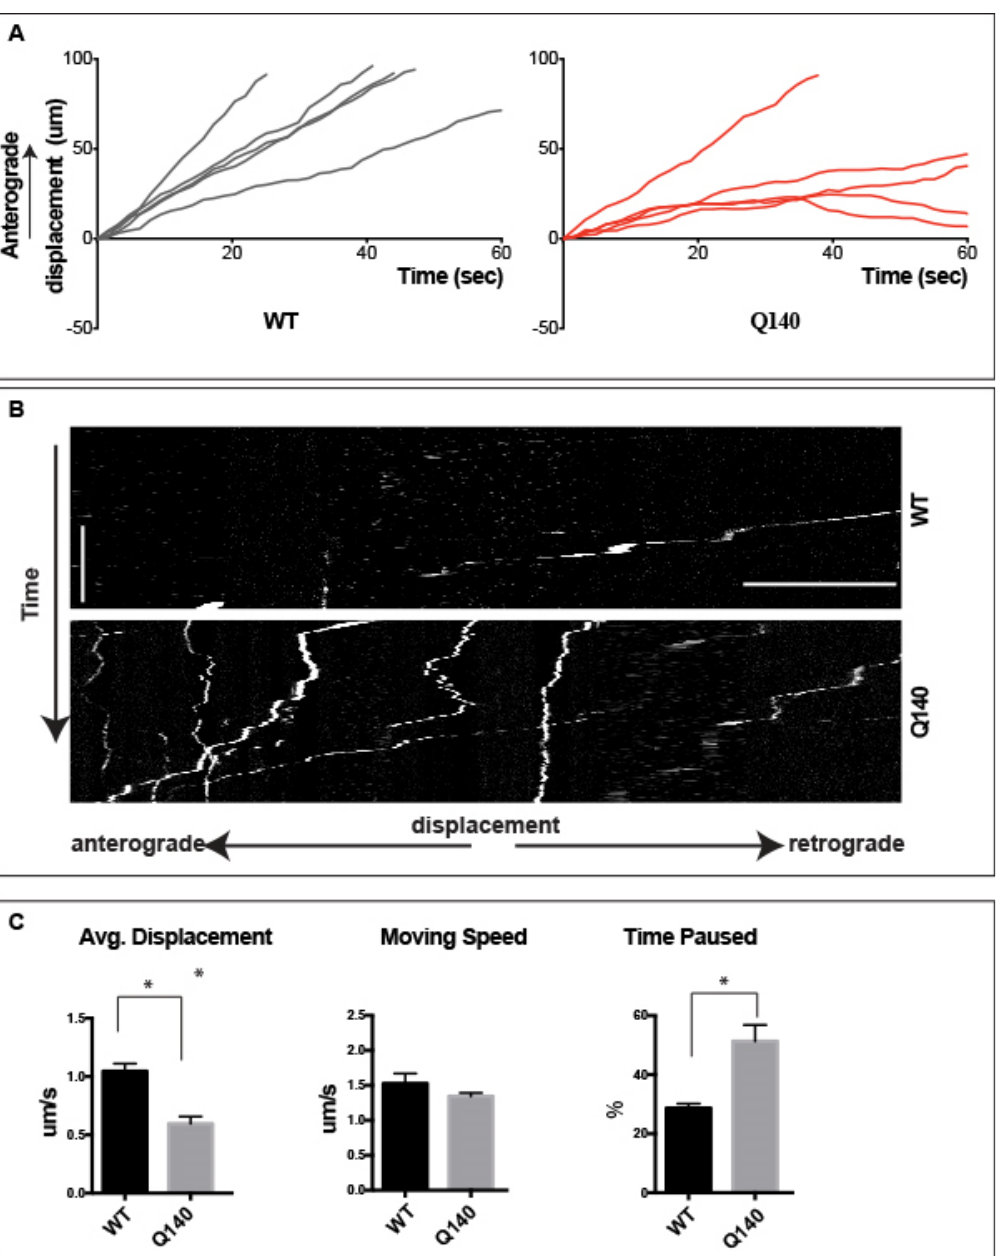
Figure 3. Perturbed anterograde transport of QD-BDNF in Q140 cortical axons. ( A ). Displacement vs. time plots of QD-BDNF anterograde transport in axons of WT (gray) and Q140 (red) cortical neurons. ( B ). Kymographs detailing single-molecule cortical axon transport. ( C ). Bar graphs quantifying averaged displacement, moving speed and percent time paused for QD-BDNF in WT and Q140 cortical axons. Data were from three individual repeats. Vertical Scale bar = 1 min, horizontal scale bar = 5 µm, * p < 0.01.